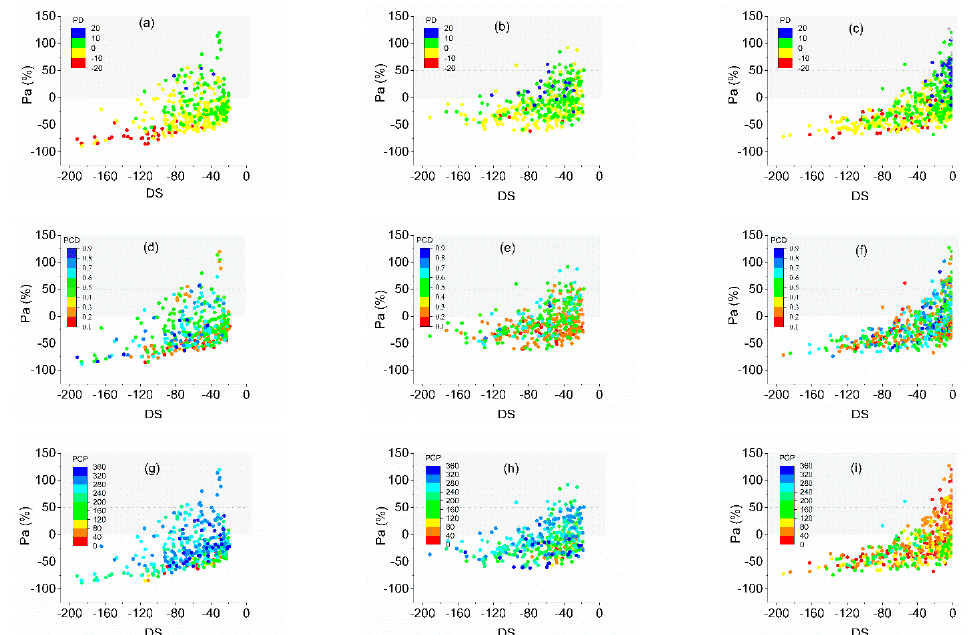
Figure 11. Correlation between drought intensity and precipitation and its heterogeneity in the eastern region (east of 106° E) (columns 1–3 are spring, summer, and autumn; ( a – c ) is PD, ( d – f ) is PCD, ( g – i ) is the PCP). Current drought monitoring and prediction focus mainly on the precipitation amount within a period, such as the percentage of precipitation anomaly (Pa), the stand- ardized precipitation index (SPI), and even the standardized precipitation evapotranspi- ration index (SPEI) [35]. In arid regions, it is generally believed that less precipitation is the direct cause of the drought. However, basing drought prediction solely on precipita- tion amounts can lead to incorrect conclusions [15]. For instance, if a prolonged dry period is followed by heavy precipitation events, the period may be concluded to be wet on av- erage [16]. Our results show that although less precipitation is the leading factor of drought in the dry rain-fed agricultural areas of northern China, the impacts of precipita- tion heterogeneity are significant. In the study area, approximately 30–50% of droughts in seasons with abundant precipitation were caused by heterogeneous distribution. There- fore, when diagnosing seasonal drought, the total precipitation and the precipitation het- erogeneity should be considered. In this way, drought monitoring can be performed ac- curately, and early warning can be given. 4. Conclusions 1. There were 1–3 drought processes per year during the study period in eastern Gansu province. There were more drought processes in the eastern and central northern re- gions than in other regions. The drought processes were mainly intra-seasonal droughts, accounting for 61.4% of the total drought processes. They occurred once